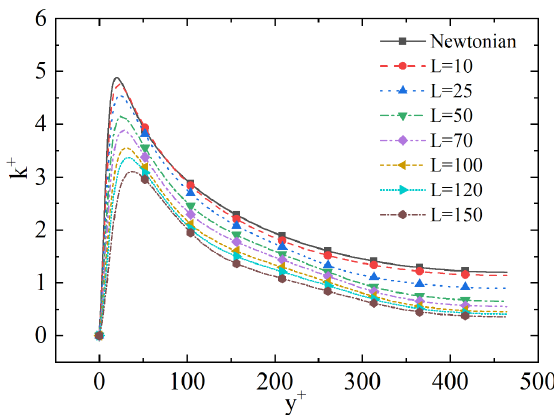
 ) of different maximum extensibility of the